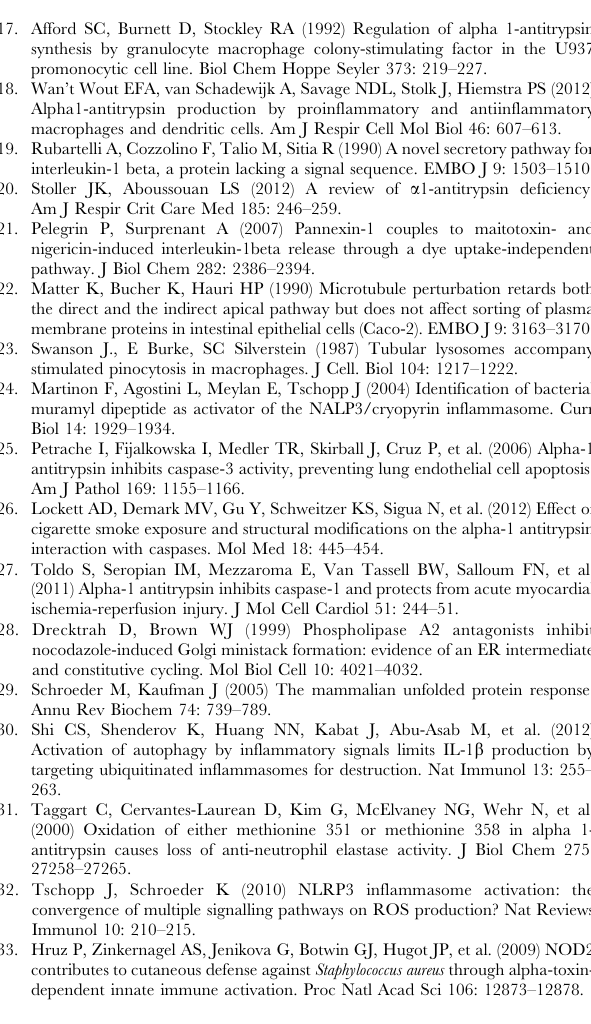
squares) cultured with PMA for 5 days were pulsed for 18 hours with graded concentrations of TLR ligands peptidoglycan, flagellin, LPS, or MDP. IL-1 b was assessed in supernatants by ELISA. Figure S2 Pro-IL-1 b and IL-1 b mRNA Detection in Transfected THP-1 Cells. THP-1 cells stably transfected with plasmids encoding wild type A1PI (A1PI-M) or Z isoform A1PI (A1PI-Z), or empty vector control plasmid, were treated for 18 hours with PMA or DMSO vehicle. A) Level of IL-1 b mRNA normalized to b -actin was detected by Q-PCR; mean of triplicate wells is shown. B) Level of pro-IL-1 b protein in whole cell lysate was detected by ELISA; mean of duplicate wells is shown. Asterisks denote P # 0.05.